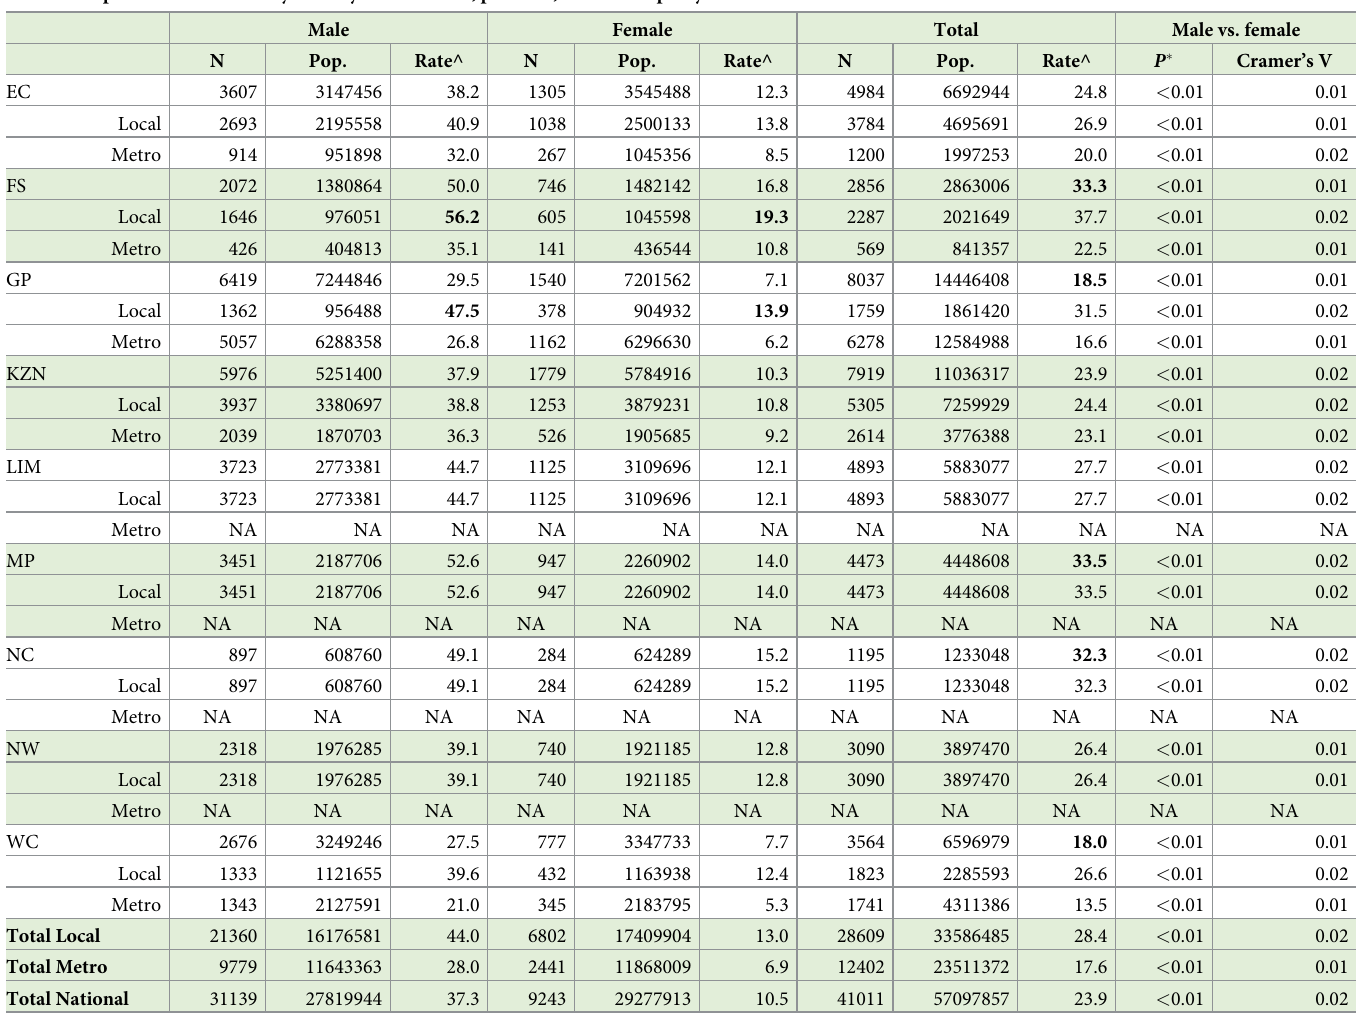
Table 4. Population-based fatality rates by road user sex, province, and